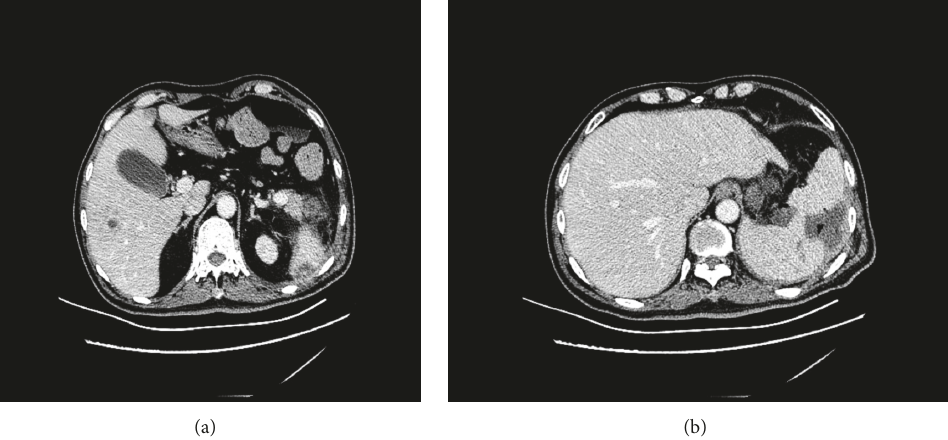
Figure 2: A contrast-enhanced CT scan of abdomen showed (a) rounded hypodense lesion with central low attenuation in the right lobe of the liver (suggestive of liver abscess) and (b) hypodense splenic air-filled lesion with an irregular wall (suggestive of perisplenic